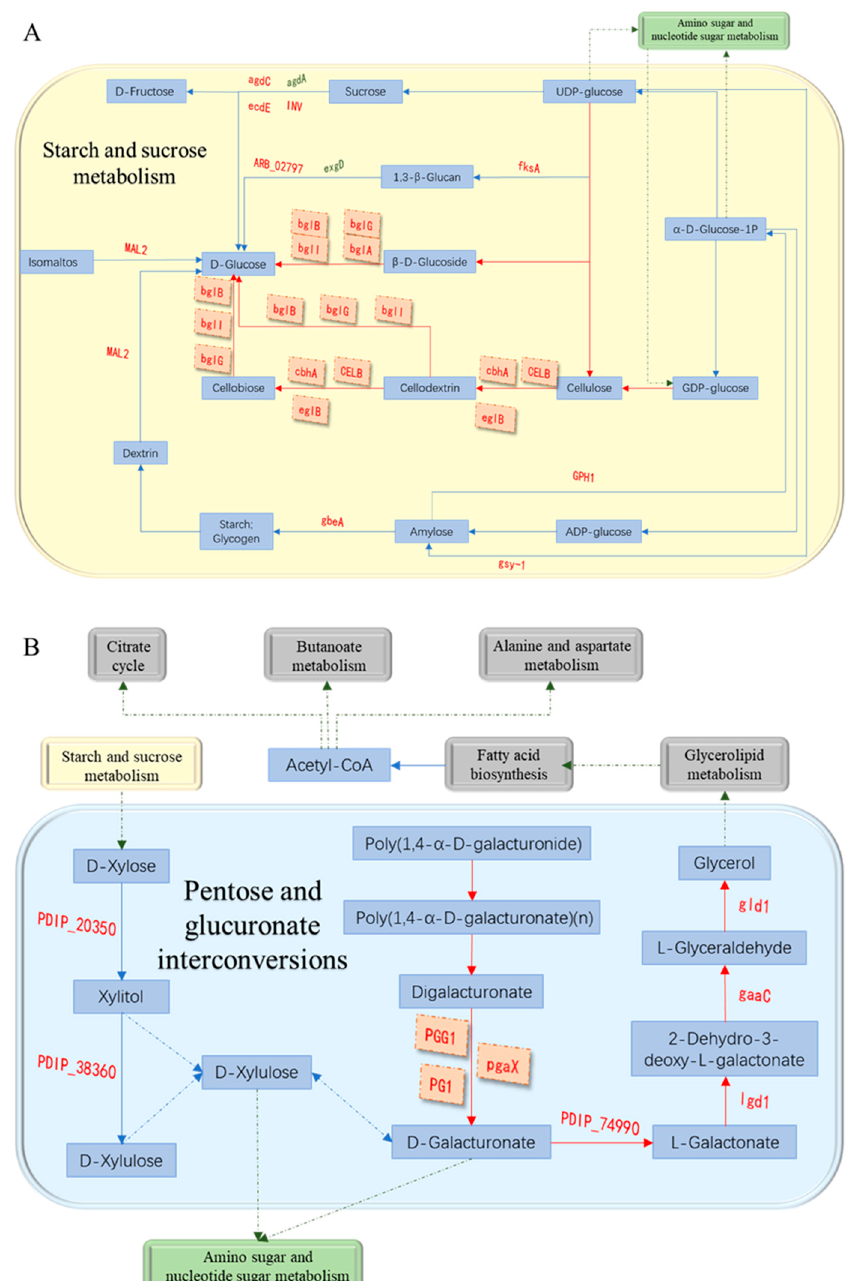
Figure 7. Cell wall degrading enzymes-related pathways. ( A ): Cellulase-related pathways; ( B ): pectinase-related pathways.